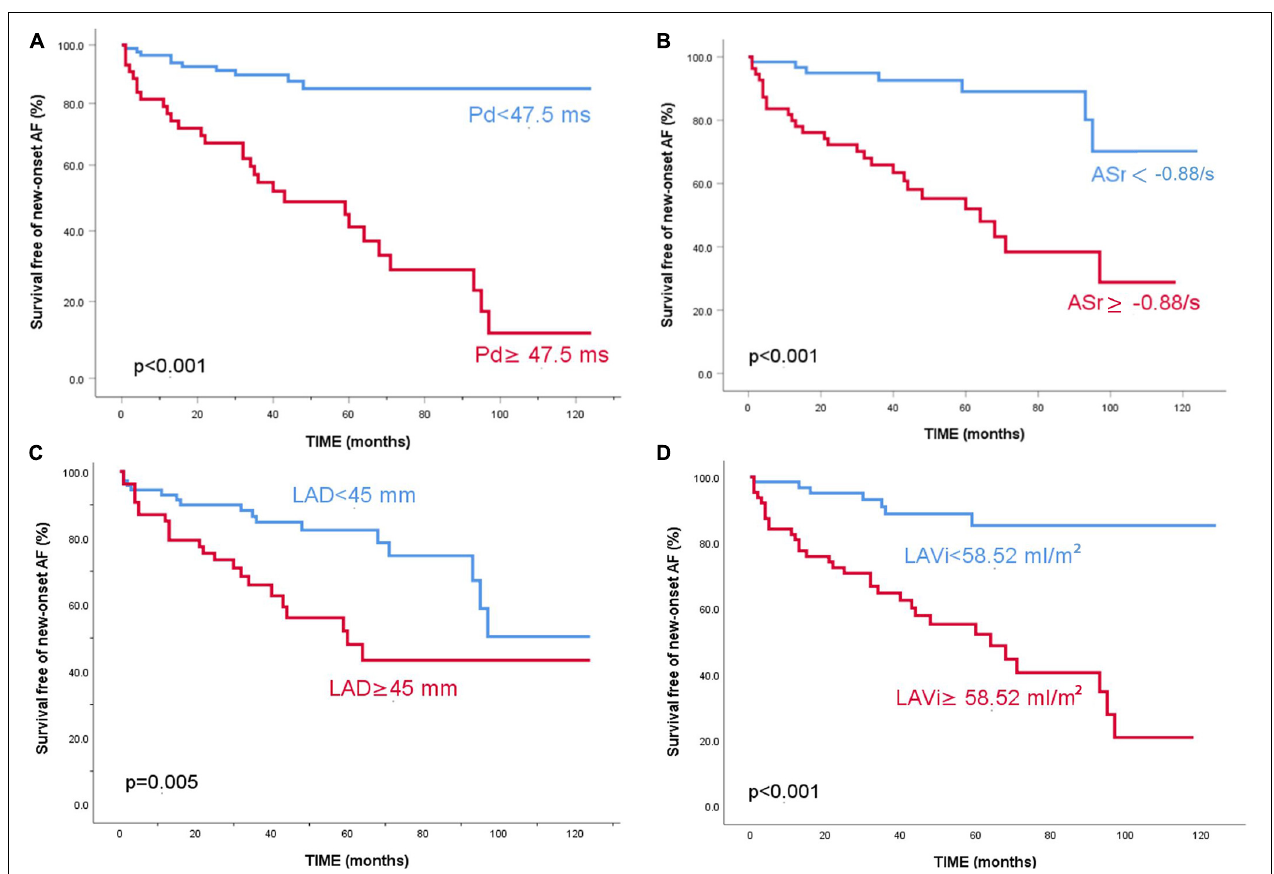
FIGURE 2 | Kaplan–Meier survival curves free of new-onset atrial fibrillation for the entire study population. Patients are stratified according to P wave dispersion (A) 5-year survival free of events of 85% vs 41.2%, p < 0.001, ASr (B) 5-year survival free of events of 89.1% vs 52%, p < 0.001, LAD (C) 5-year survival free of events of 82.4% vs 48.1%, p = 0.005 and LAVi (D) 5-year survival free of events of 85.2% vs 52.2%, p <